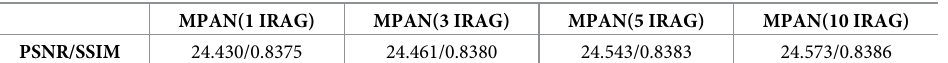
Table 2. Ablation study about IRAG numbers.